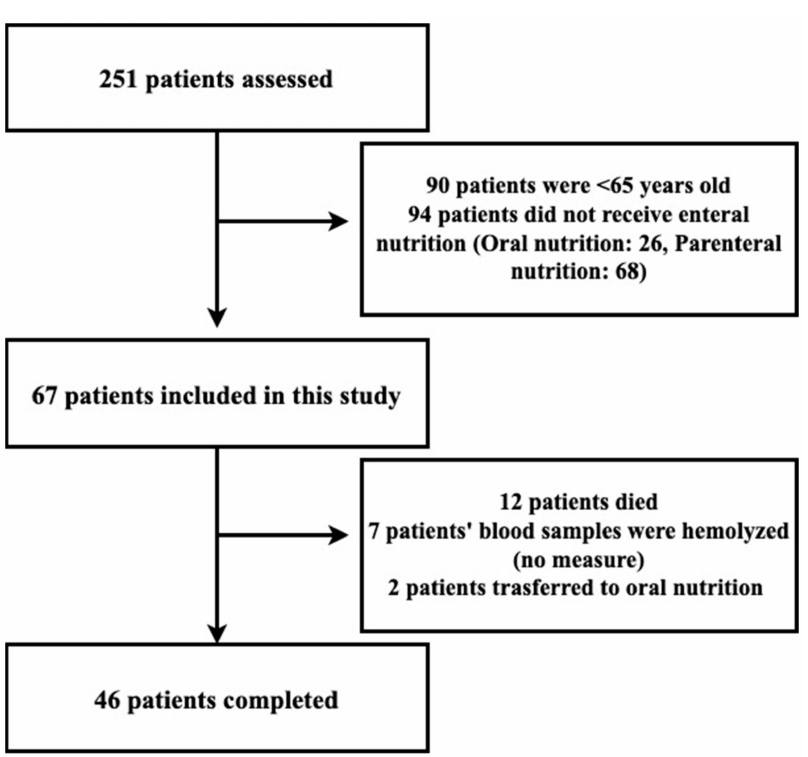
Figure 1. Flowchart of the study. The mean age of the patients was 72 ± 6 years, and the median value of males (IQR) was 25 (54.3). The median (IQR) BMI of the patients was 22.0 (20.9–29.0), the mean APACHE II was 19.8 ± 6.98, and the median (IQR) Charlson comorbidity index was 6 (4–8). Metabolic disorders ( n : 17, 37.0%) and sepsis/septic shock (26.1%) were the most common reasons for hospitalization in the intensive care unit. Diabetes mellitus was present in 16 (34.8%) of our patients, and at the same time, all the patients had received insulin therapy. The most common comorbidity in our patients was hypertension, in 29 patients (63.0%). The malnutrition risk was found in 32 patients (70.0%). The median percentage of reaching the daily energy requirement was 65.9 ± 34.1 during the 4-day follow-up. The daily energy requirements and the amount they can actually take are presented in Table 1. The mean daily protein intake was 0.4 ± 0.27 g/kg/day on the first day and 0.8 ± 0.47 g/kg/day on the fourth